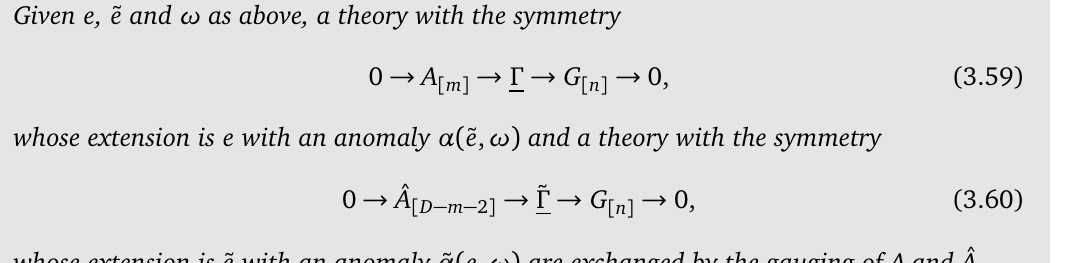
line 2 wall, there is 2